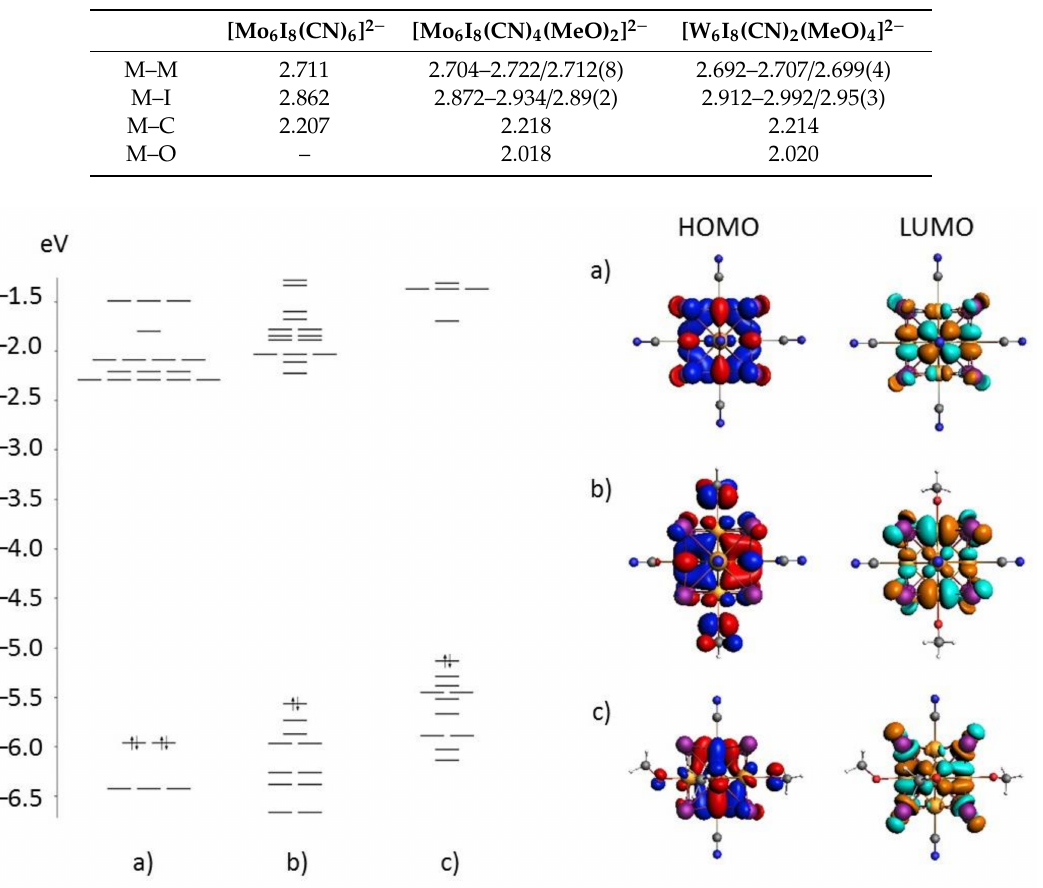
Table 2. Calculated interatomic distances within [Mo 6 I 8 (CN) 6 ] 2 − , trans -[Mo 6 I 8 (CN) 4 (MeO) 2 ] 2 − and